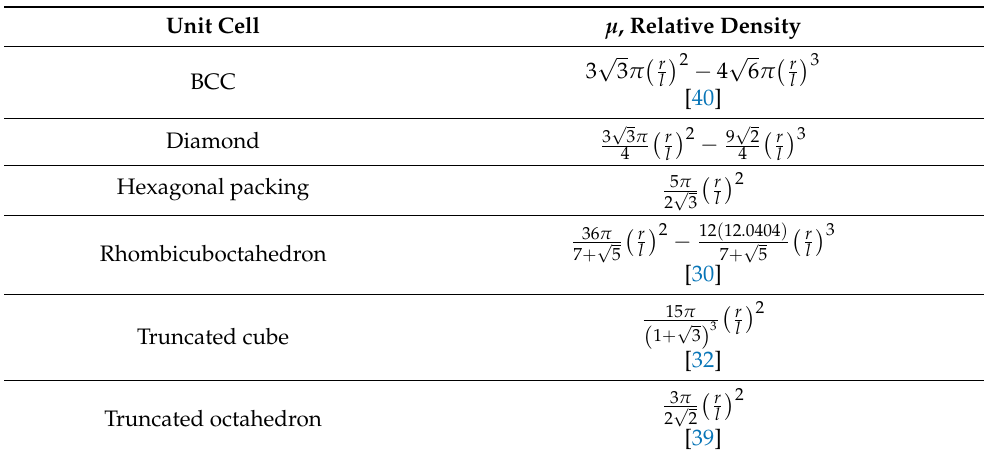
Table 5. Relative density relationships for different unit cell